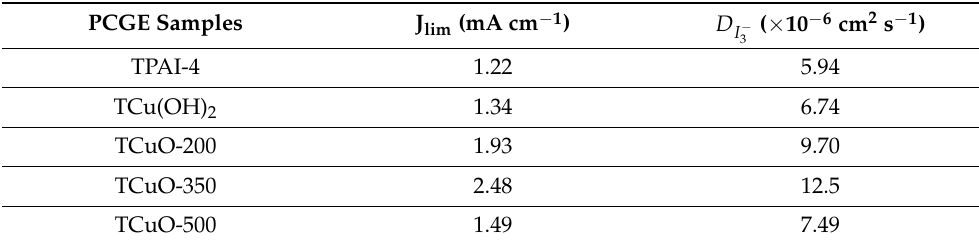
Table 3. The value of limiting current density and apparent diffusion coefficient of triiodide for all PCGE